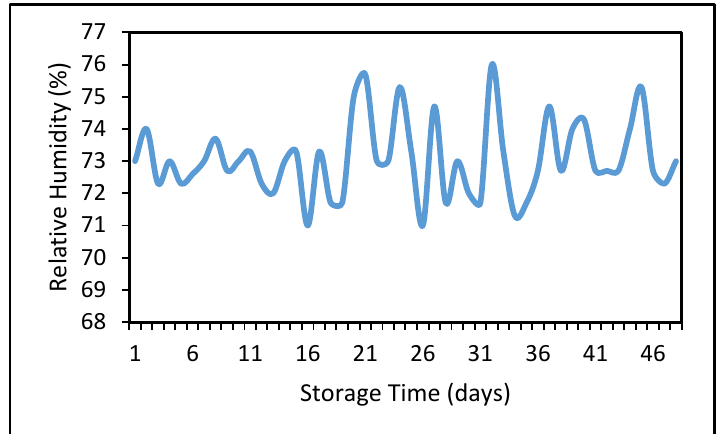
Figure 5. Ambient relative humidity during the storage of breadfruit seeds.